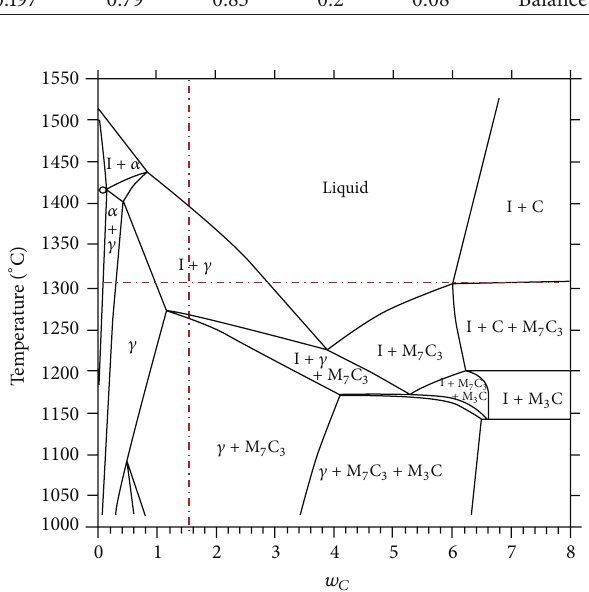
Figure 1: Binary phase diagram of AISI D2 tool steel with variable carbon content